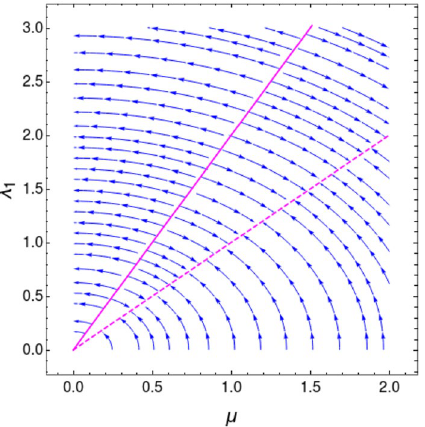
(cid:31) µ 1 . RG flow are away from the line = −